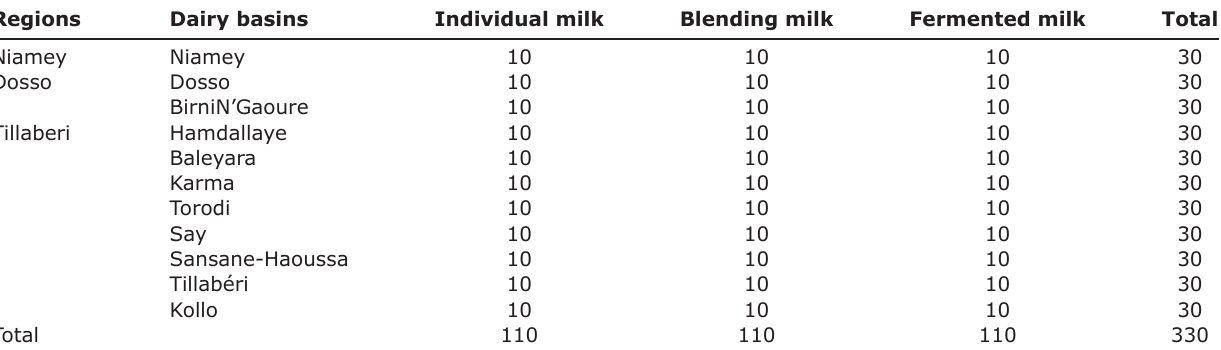
Table-1: Distribution of the number of samples taken by dairy basins. Regions Dairy basins Individual